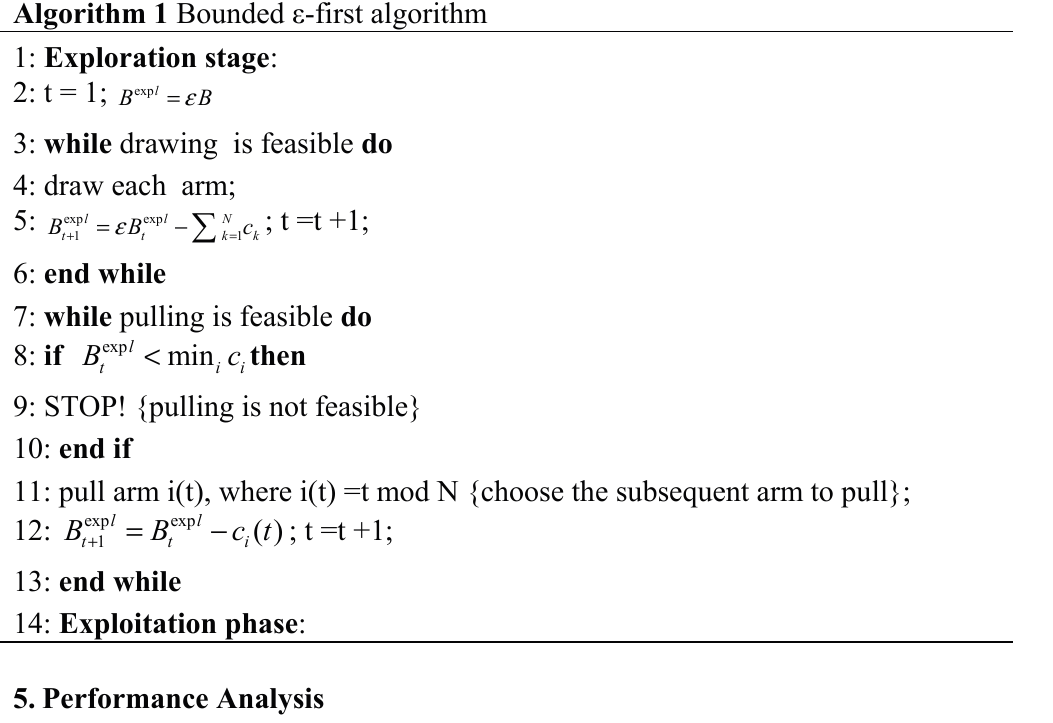
Algorithm 1 Bounded ε -first